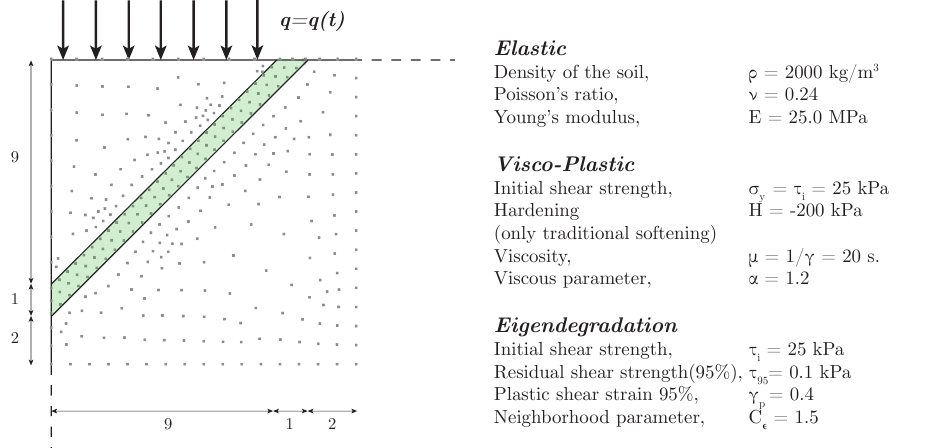
Figure 11. ( Left :) Geometry of the vertical cut analyzed through eigendegradation and softening models and the location of the weak layer and the loaded zone (units in meters). ( Right ): Parameters of the employed models.